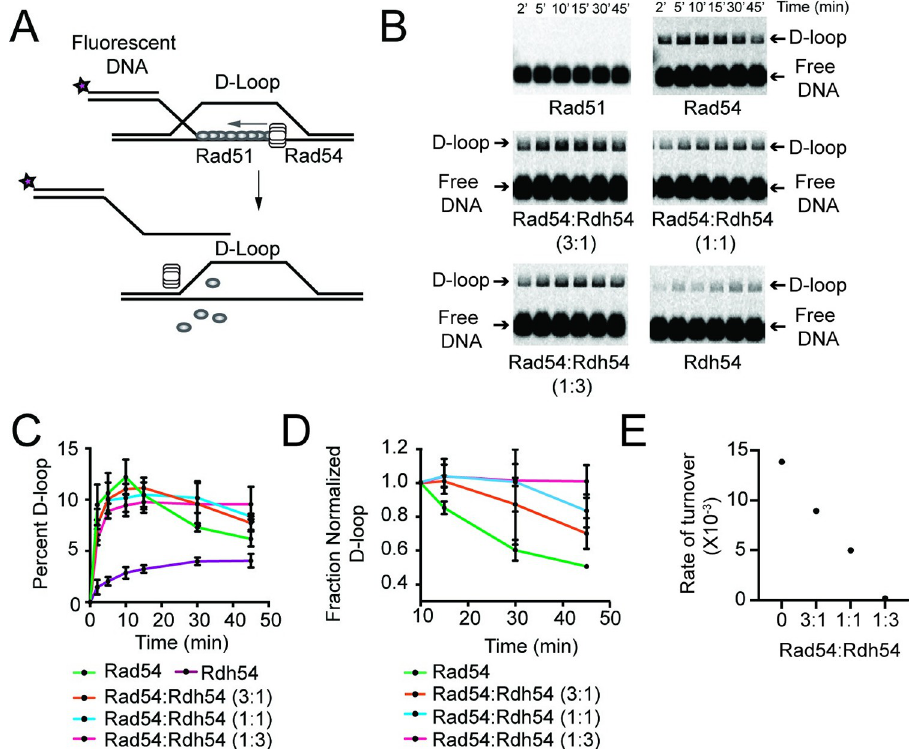
Fig 3. Rdh54 inhibits Rad54 mediated D-loop turnover. (A). Cartoon diagram illustrating the experimental design for monitoring Rad54 mediated D-loop maturation. The recipient DNA in this experiment is 21 nt of homologous DNA with 36 bp of non-homologous duplexed DNA (B). Representative agarose gels illustrating D-loop turnover for Rad51 alone, Rad51+Rad54 (30 nM), Rad51+Rad54+Rdh54 (10 nM), Rad51+Rad54+Rdh54 (30 nM), Rad51+Rad54 +Rdh54 (90 nM), Rad51+Rdh54 (30 nM). (C). Quantification of D-loop turnover experiment as a Fraction of D-loop. The error bars represent the standard deviation of three independent experiments. (D). Normalized quantification of D-loop turnover. Experiments were normalized by setting the maximum fraction D-loop (10 min) to one and normalizing the other time points to that value. The error bars represent the standard deviation of three independent experiments. (E). Graphical depiction of fits of the D-loop turnover phase (10–45 min) of the reaction. The rates are represented from the slope of the best fit line for 0, 3:1, 1:1, and 1:3 molar ratios of